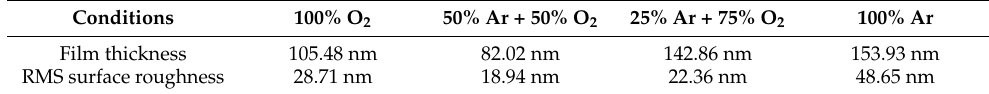
Table 1. The film thickness and RMS surface roughness of IGZO thin films.